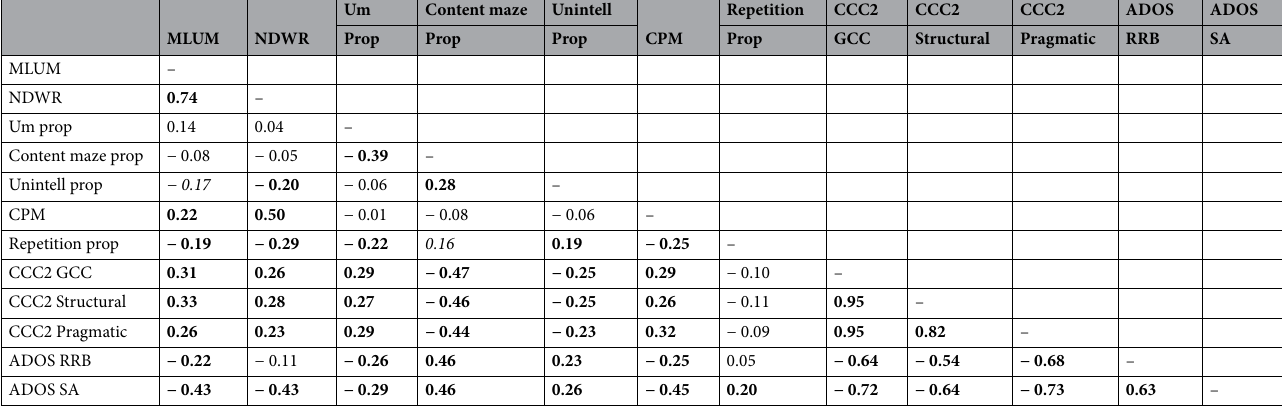
The baseline model 0 classification accuracy was 62.89%. As shown by the Wald test statistic, this effect was largely driven by IQ. Age did not significantly contribute to the model; however, we adjusted all subsequent models on both IQ and age as they are developmentally relevant metrics. Models 1-7 had classification accuracy values ranging from 63.52% for NDWR to 75.47% for content maze proportion. The model for content maze proportion had the highest accuracy out of the seven models by over five percentage points. Specificity (the true negative rate) was 71.91% at the baseline model, reflecting the strong effect of IQ. How- ever, sensitivity (the true positive rate) was only 51.43%. The models for MLUM and NDWR were not significant (Wald test: p > .45 ) and resulted in very modest improvements in sensitivity while having lower specificity